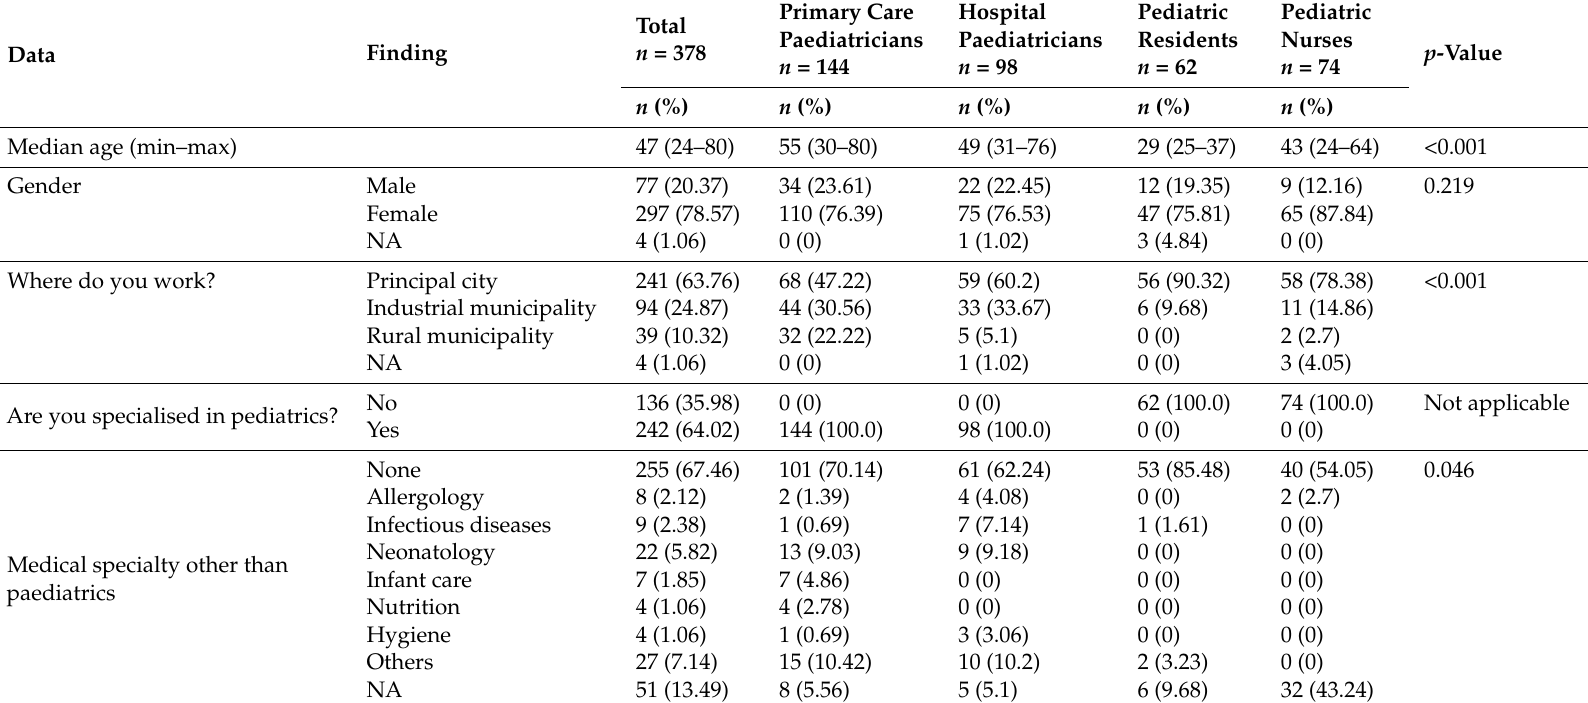
Table 1. Demographic data of responding healthcare